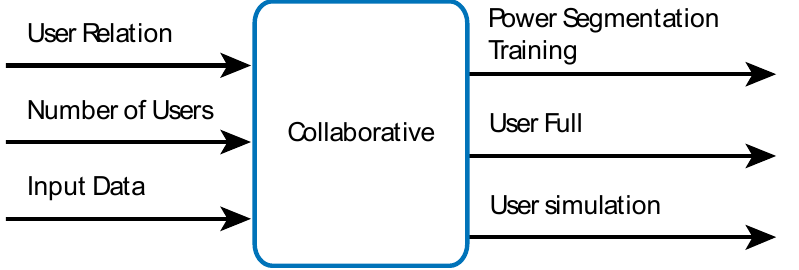
Figure 4. Inputs and outputs collaborative model.